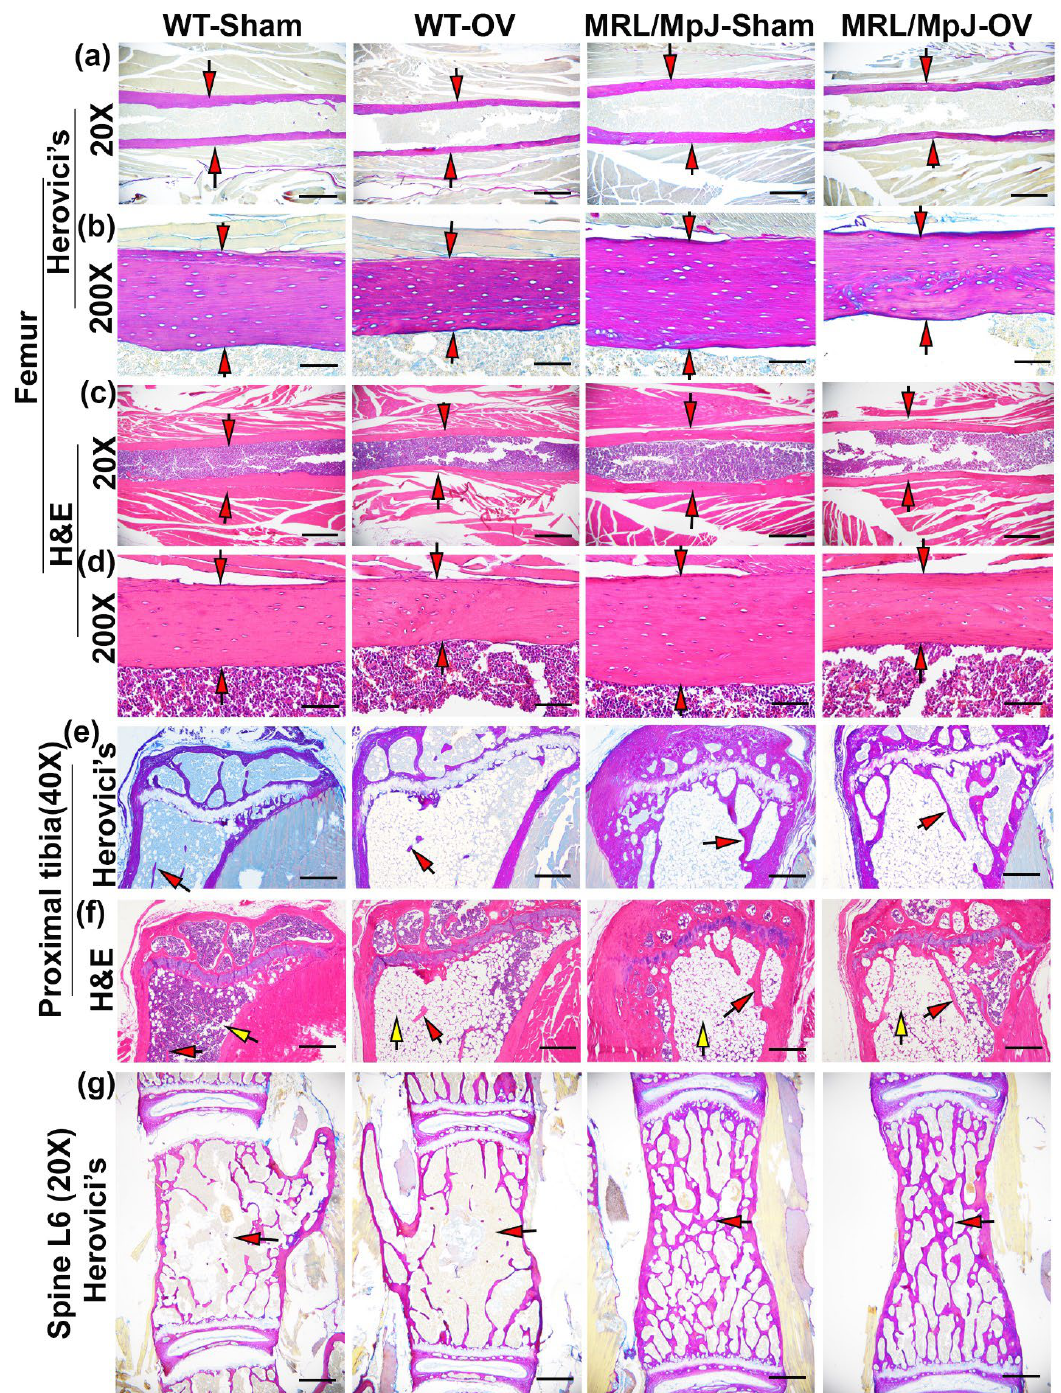
at 20 × magnification, the WT-OV and MRL/MpJ-OV mice both showed relatively thinner femoral cortical bone as indicated by red arrows, which correlates with the micro-CT results (Figure 7c). At 200 × magnification, both the WT-OV and MRL/MpJ-OV cohorts had thin- ner femoral cortical bone compared to the WT-Sham and MRL/MpJ-Sham cohorts. In all groups, osteocytes were well-organized and there were no pathological changes observed in any group (Figure 7d).